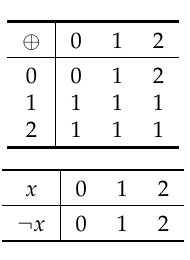
Table 3. Operations Tables for Independence of ( MV 3 )